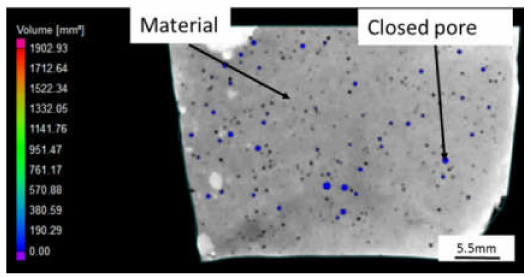
Figure 7. CT cross-section images through composite 1 of sample S1: color map is used to indicate the pore volume